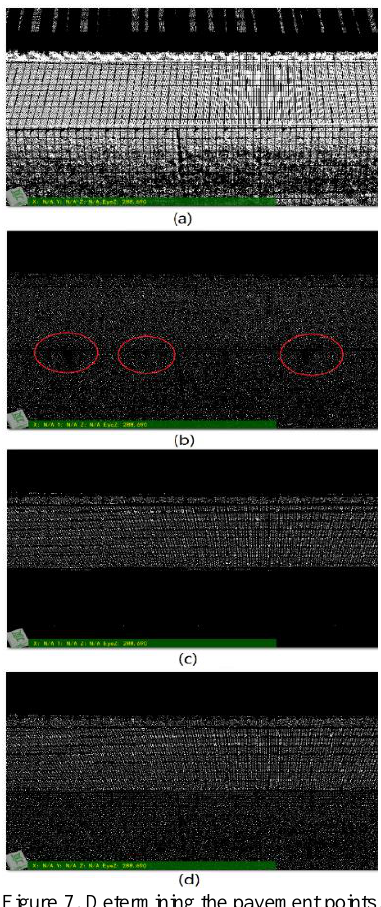
Figure 7. Determining the pavement